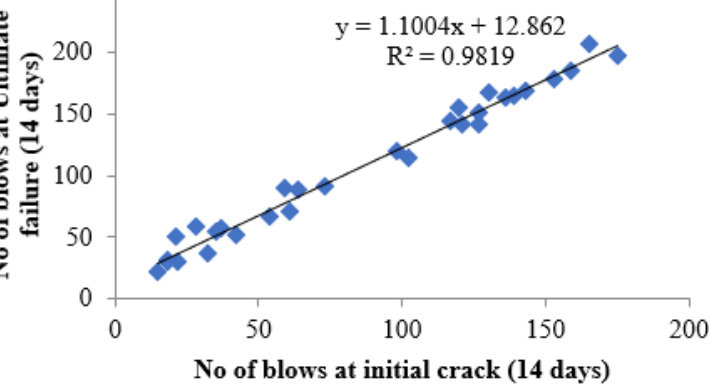
Figure 14. Prediction of ultimate impact resistance at 14 days.